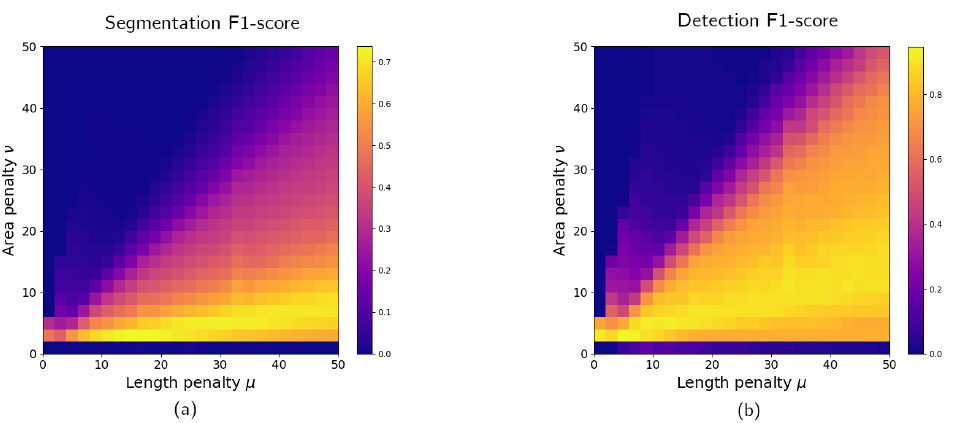
Figure 8. Dependency of F1-score on length penalty µ and area penalty ν for different tasks: image segmentation ( a ) and foreign object detection ( b ). For segmentation, the F1-score is computed using a ground truth segmentation known for every sample and averaged over all images from the dataset containing a defect. For detection, the metric is calculated on a sample level for the entire dataset consisting of the objects with and without a